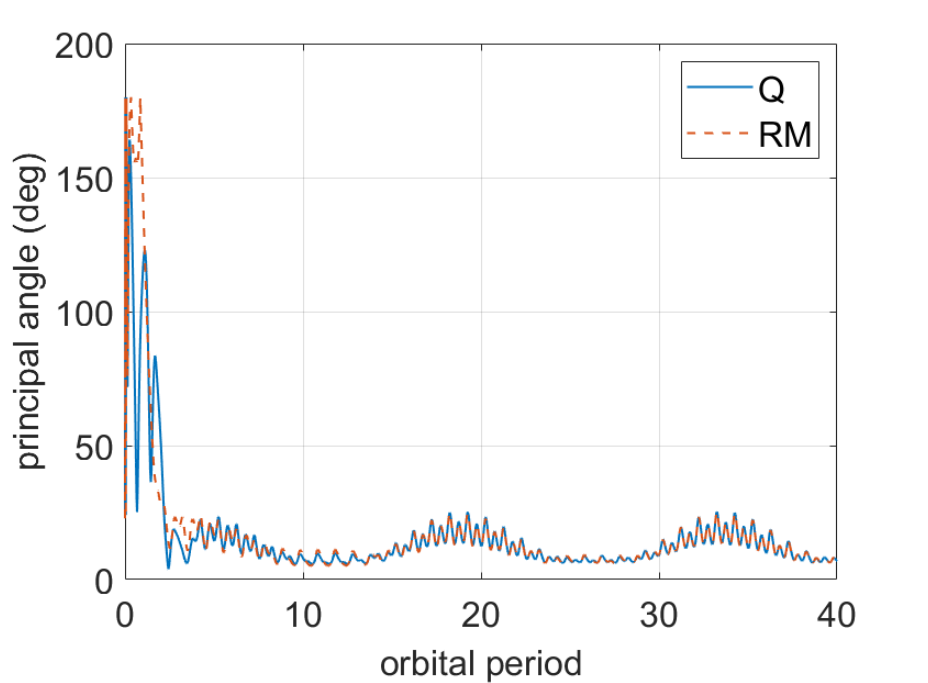
Figure 2. Time histories of principal angle using quaternion feedback (Q, blue solid line) and using rotation matrix feedback (RM, red dashed line) (single run of the Monte Carlo campaign for the perturbed